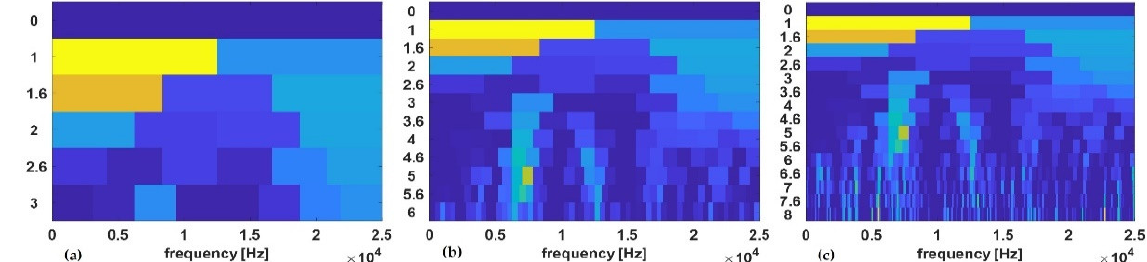
Figure 5. Kurtogram of healthy bearing at: ( a ) Decomposition Level 3, ( b ) Decomposition Level 6, and ( c ) Decomposition Level 8.